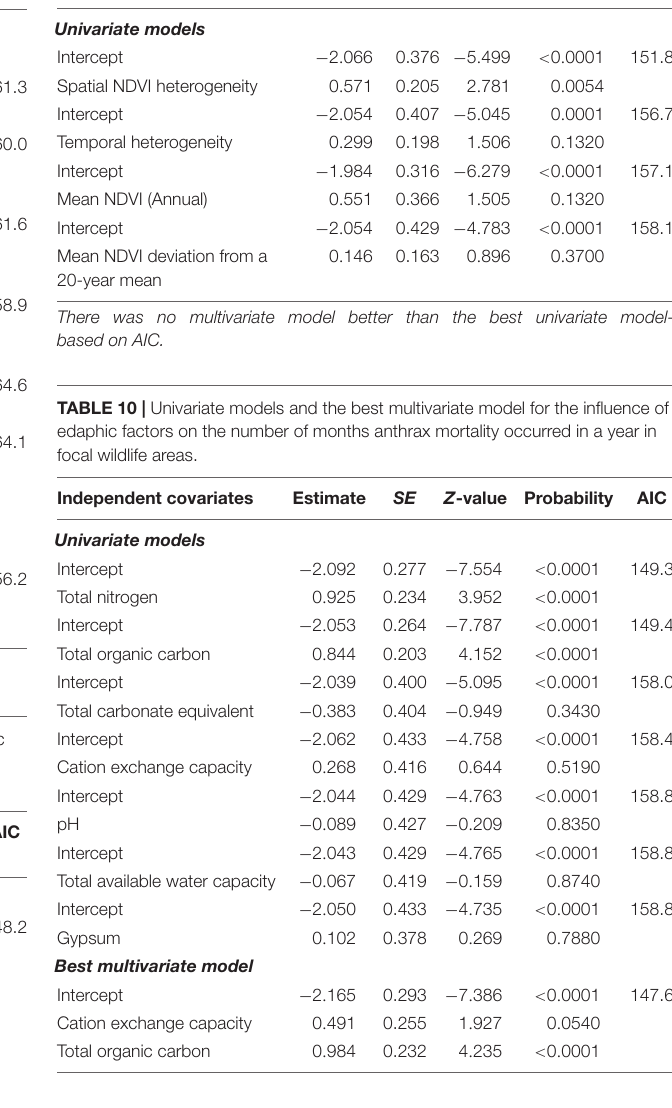
TABLE 11 | The best multivariate GLMM model for the influence of edaphic variables and NDVI metrics on the number of months an anthrax outbreak was recorded in a year in Kenya’s focal wildlife